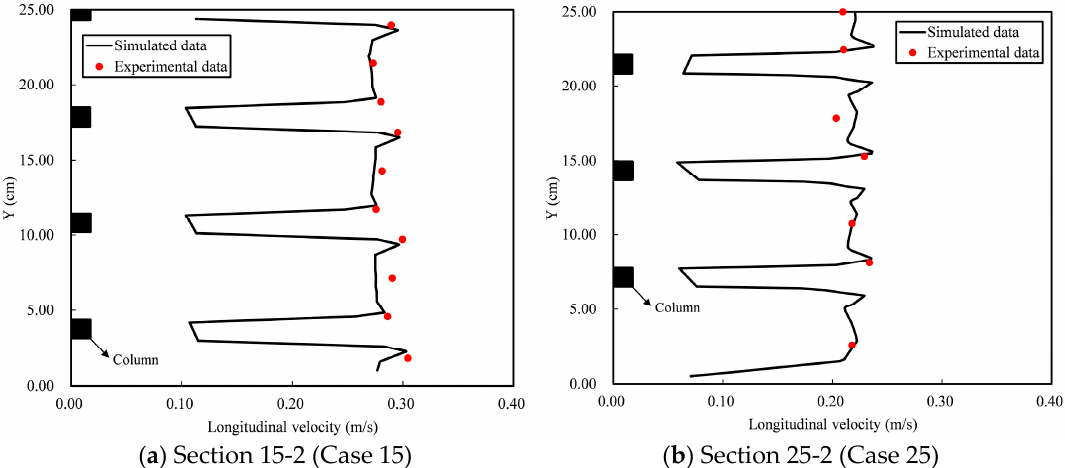
Figure 6. Distribution of the simulated results and experimental results of the surface velocity vector.